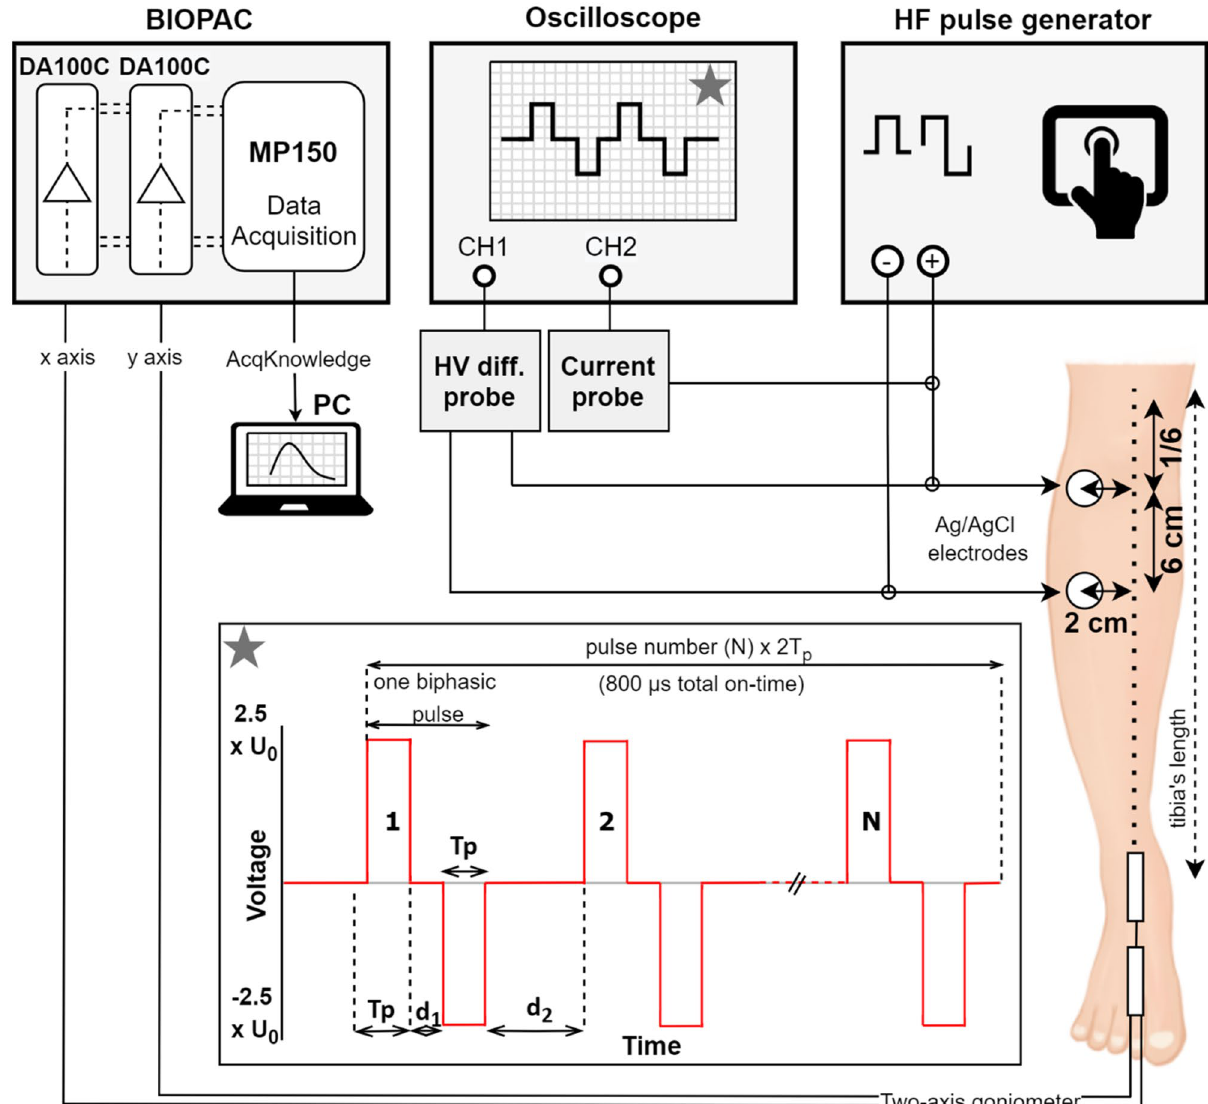
Figure 1. Experimental setup and electrodes/goniometer placement. Stimulation pulses were delivered via electrodes connected to the HF pulse generator. The electrodes (marked with circles) were placed on the right leg: the upper electrode was placed on 1/6th of the tibia’s length, the lower electrode was placed 6 cm lower. Both electrodes were placed 2 cm right lateral to the bone (left in the figure). The output pulses were monitored on an oscilloscope using high-voltage (HV) differential and current probe. Asterisk: applied pulses—biphasic pulses with 800 μs total on-time. T p -pulse width (equal for positive and negative phase), d 1 -interphase delay, d 2 -interpulse delay, N-number of pulses. The response from the ankle (muscle contraction) was acquired with twin-axis goniometer connected to the Biopac unit. The data was analyzed on a personal computer (PC) using the AcqKnowledge software. DA100C-amplifier, MP150-data acquisition